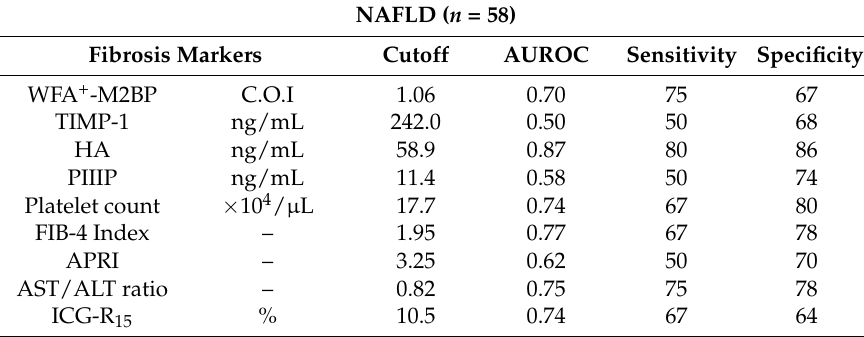
Table 1. The cutoff value and diagnostic ability of each fibrosis marker in NAFLD patients.